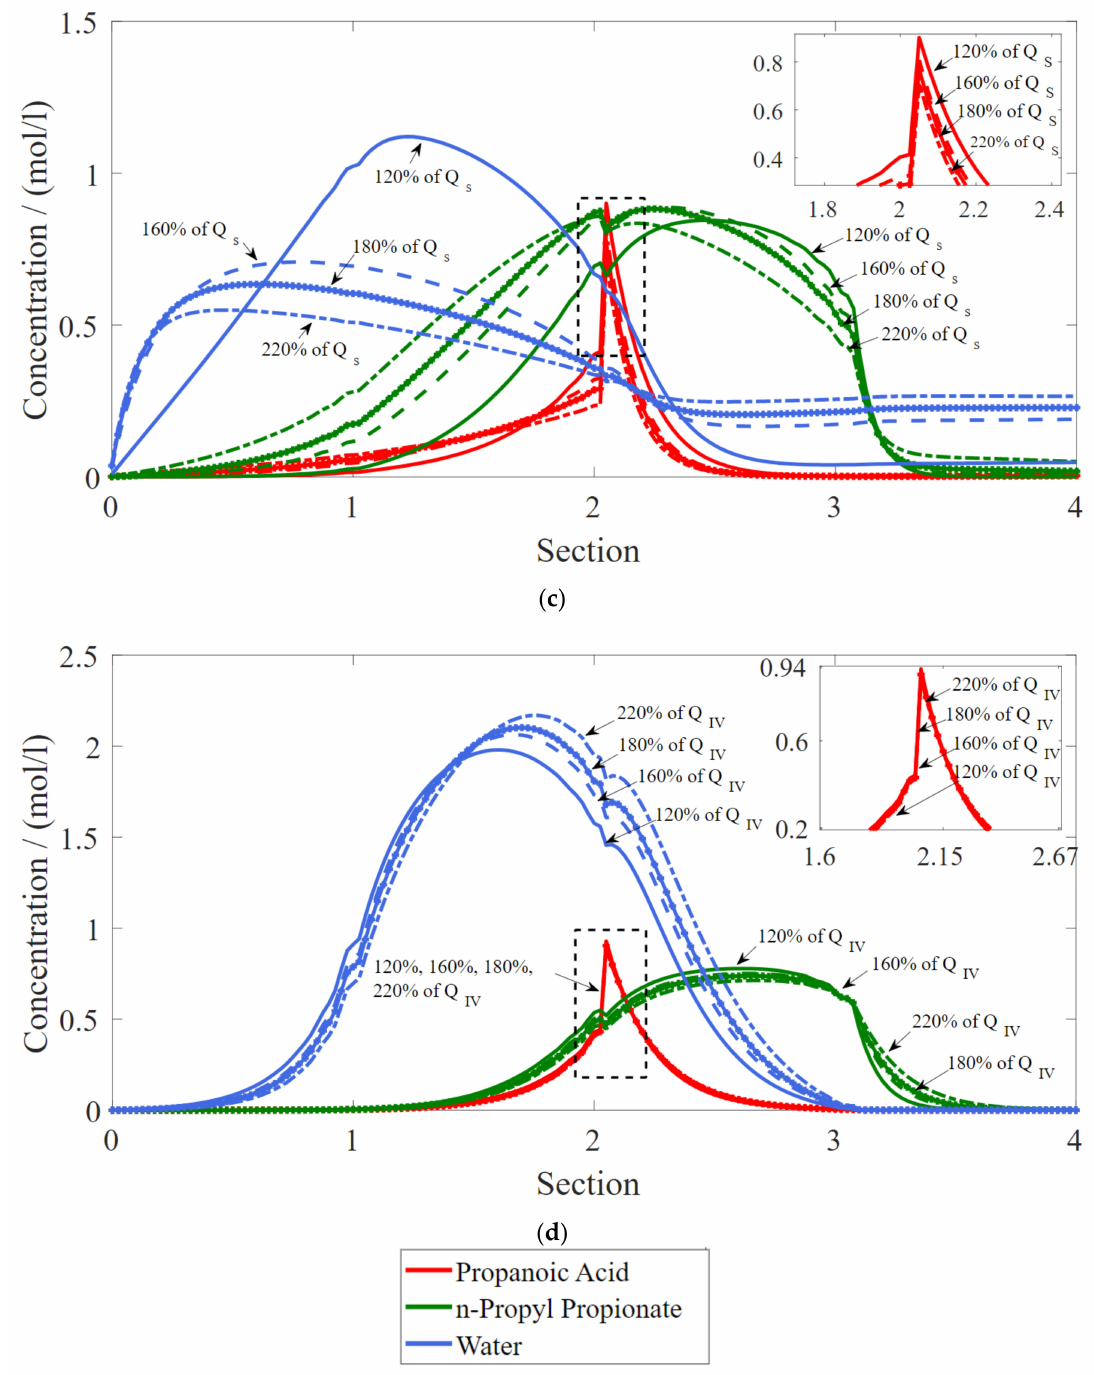
Figure 6. Concentration behaviors with variations of ( a ) feed (Q F ), ( b ) extract (Q X ), ( c ) solid (Q S ), and ( d ) recycle (Q IV ) flow